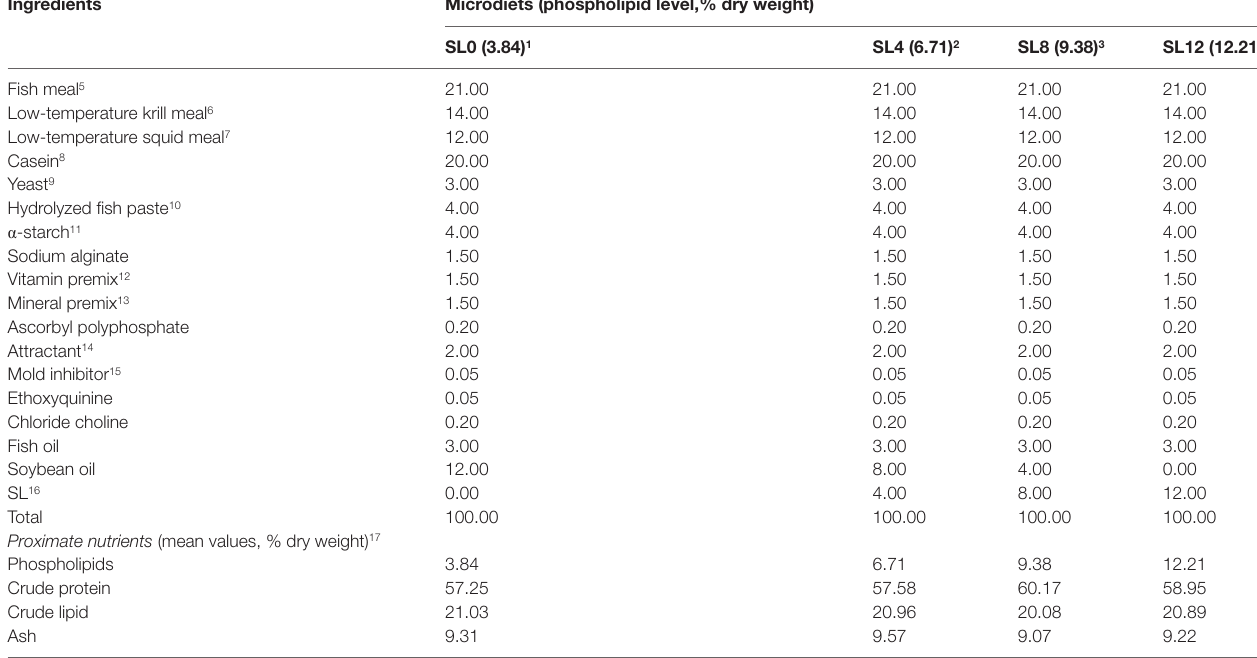
TABLE 1 | Formulation and nutrient analysis of microdiets (MDs) (%, dry weight).